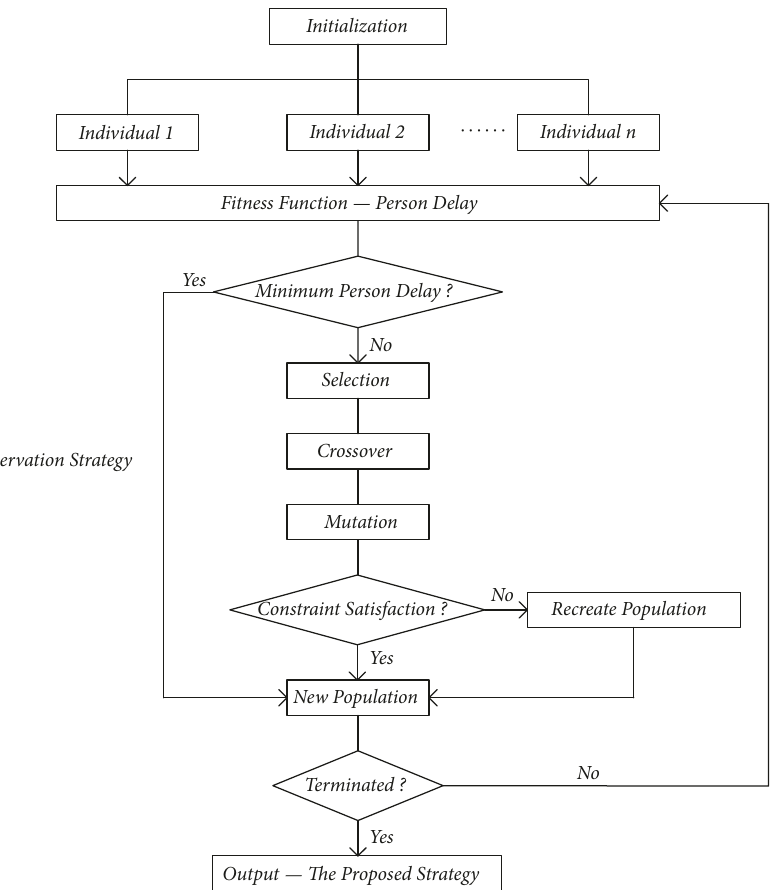
Figure 3: Flowchart of GA